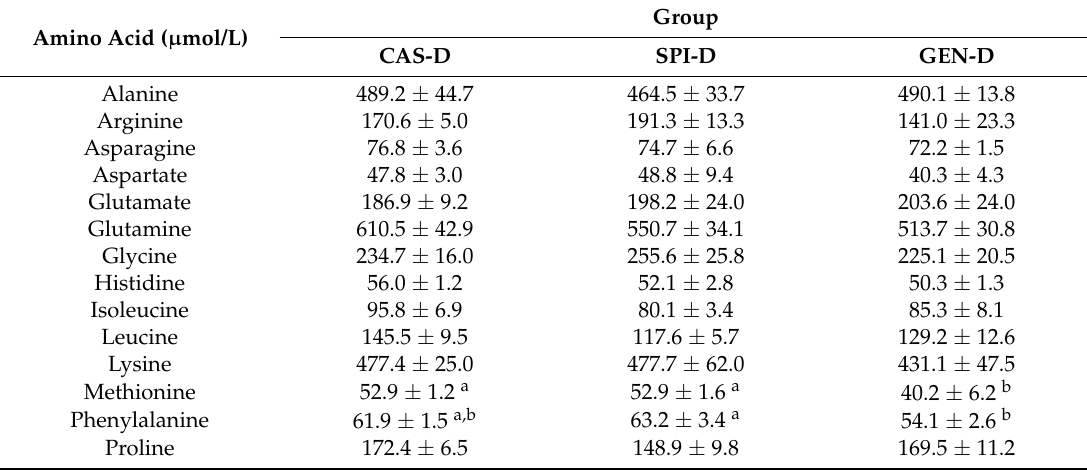
Table 3. Effects of diets on serum amino acid profiles in